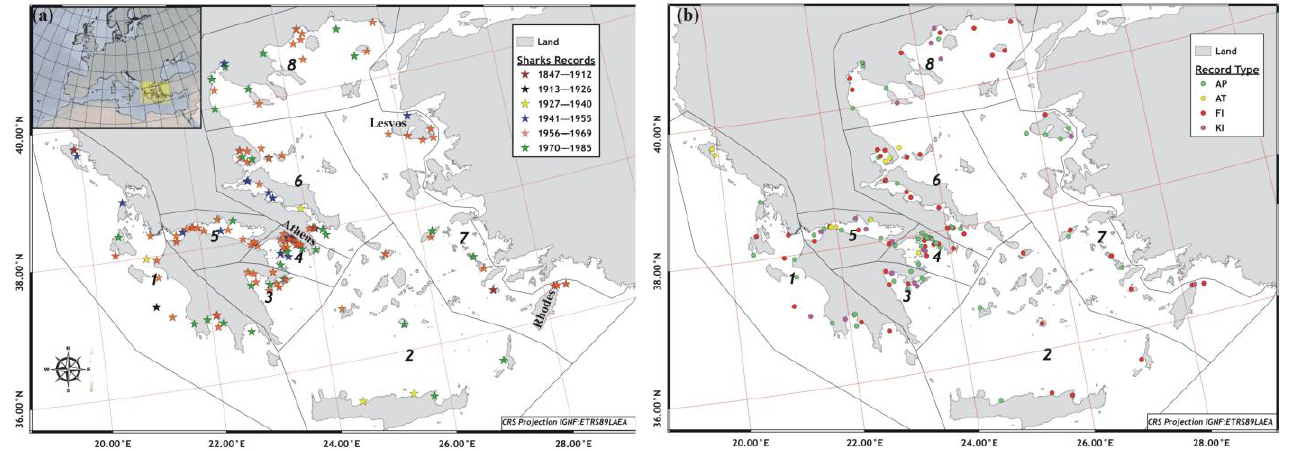
Figure 1. References on presence of sharks during the early fisheries period of the Greek fisheries in terms of: ( a ) year period and ( b ) type of reporting. 1: Ionian, 2: South Aegean – Cretan Seas, 3: Argolikos Gulf, 4: Evvoikos – Saronikos gulfs, 5: Gulf of Corinth, 6: Central Aegean Sea, 7: Eastern Aegean